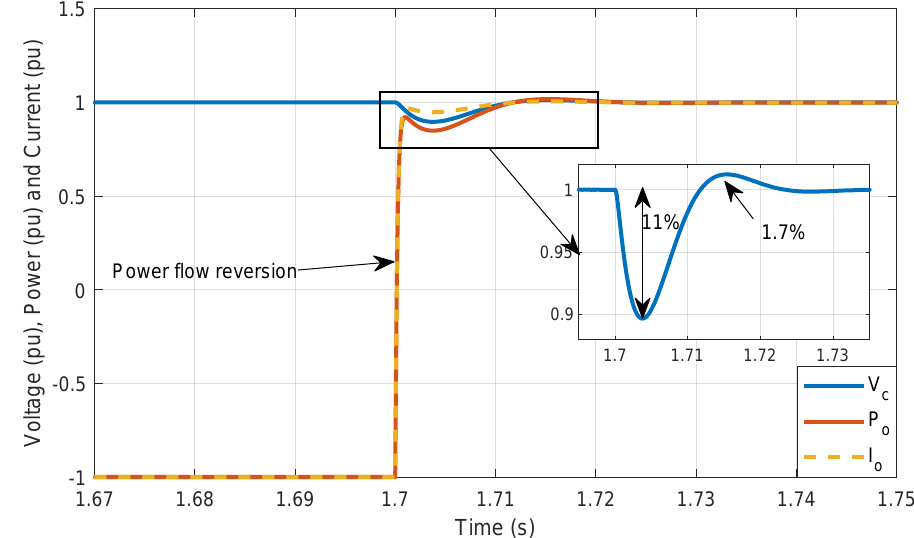
Figure 16. DC microgrid operating with bidirectional power flow and with different levels of load and generation connection resulting in different power steps imposed on the DC microgrid. In this figure, the output voltage ( v c ) , the output power ( P o ) and the load current ( i o ) are shown.